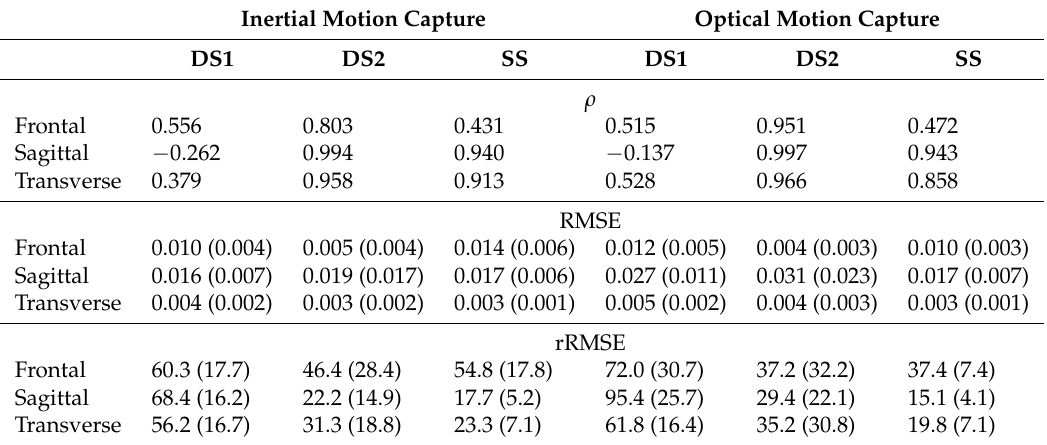
Table 6. Comparison of ground reaction moments (GRM) estimated from inertial motion capture and optical motion capture versus force plate measurements. ρ = Pearson’s correlation coefficient, are analyzed for all walking speeds during the gait cycle phases of first double stance (DS1), second double stance (DS2) and single stance (SS) for the decomposed right and left